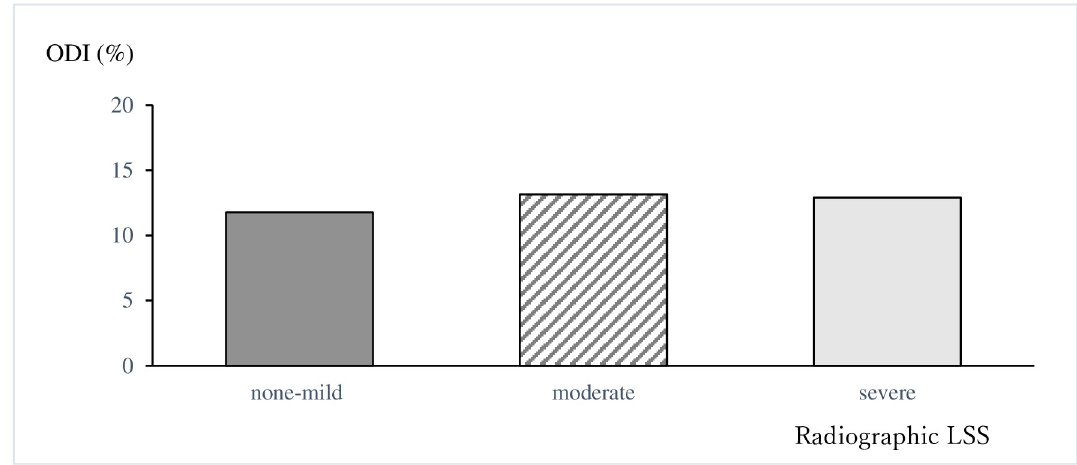
Fig 4. The average ODI for each radiographic LSS group. The average ODI for each radiographic LSS group (severe, moderate, mild/ none) is 12.9%, 13.1%, and 11.7%, respectively, which are not statistically different (P = 0.55).